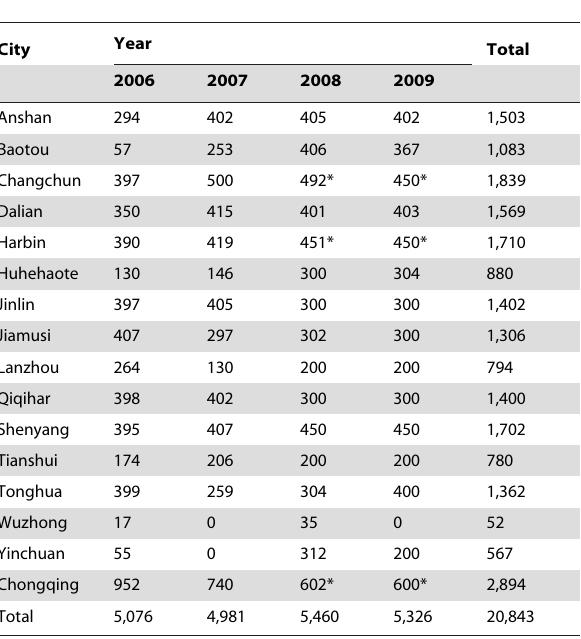
Table 1. Number of men who have sex with men (MSM) who participated in yearly surveys in 16 Chinese cities from 2006 to